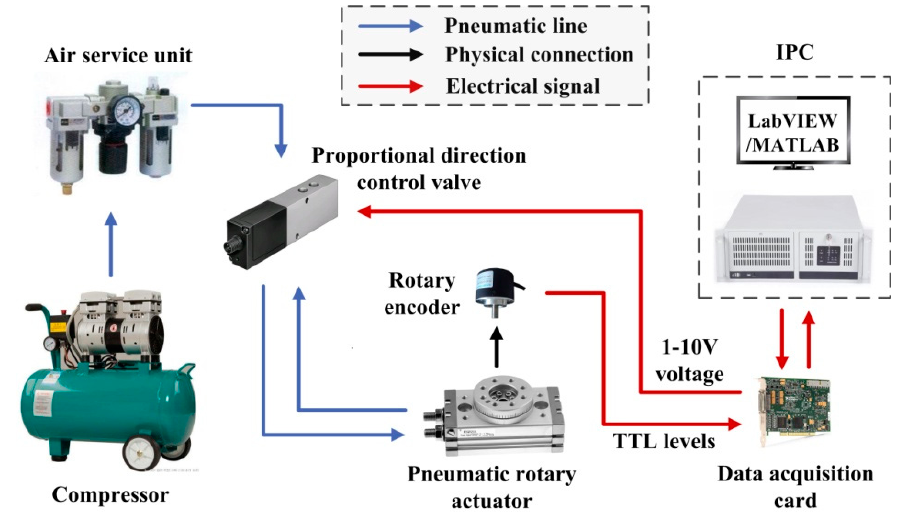
Figure 1. System configuration of the pneumatic rotary actuator servo system. Table 1. The specific models of the main components.